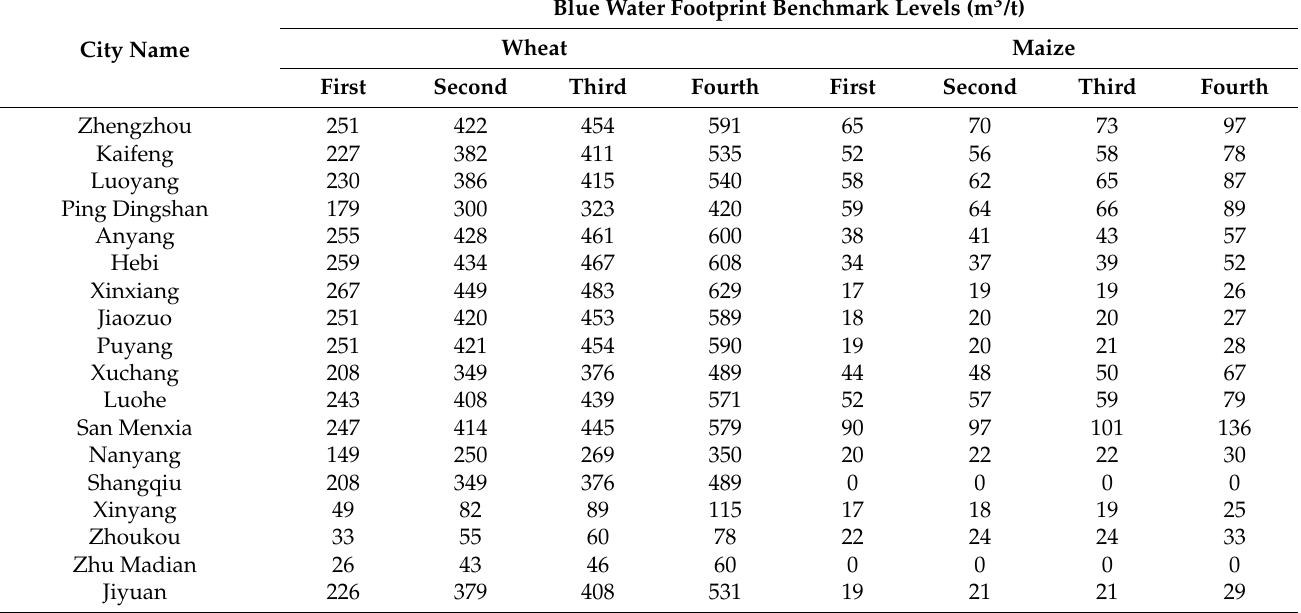
Table 2. The BWF benchmark levels in 18 cities of Henan